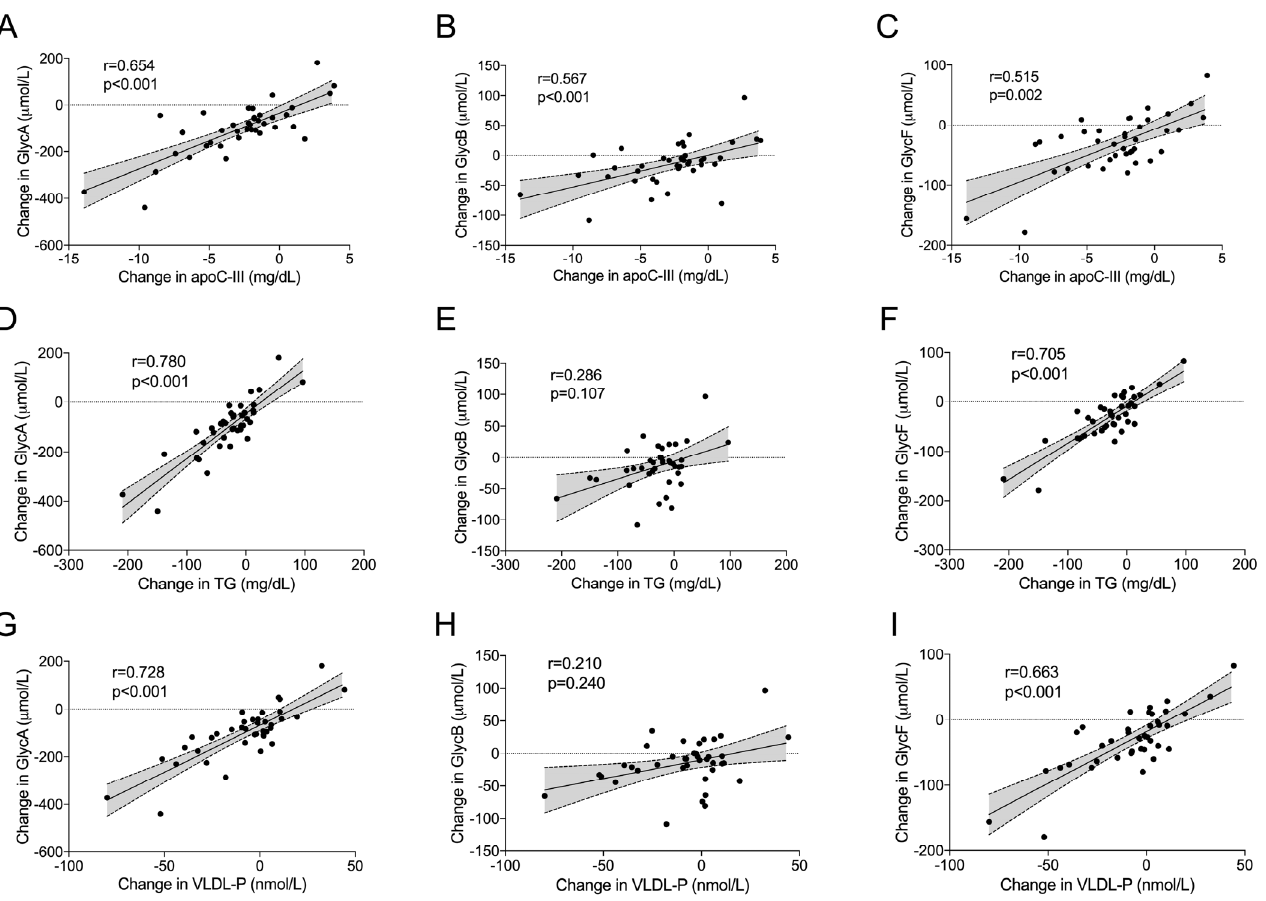
Figure 2. Correlation between change in 1H nuclear magnetic resonance (1H-NMR)—assessed glycoproteins (Glyc) and change in plasma concentrations of lipids, apolipoproteins (apo) and 1H-NMR—assessed lipoproteins. ( A – C ), Correlations between changes in Glyc concentrations and changes in apoC-III plasma concentrations. ( D – F ), Correlations between changes in Glyc concentrations and changes in plasma triglycerides (TG). ( G – I ), Correlations between changes in Glyc concentrations and changes in VLDL particle concentrations (VLDL-P). Lines represent linear regression with 95% CI.